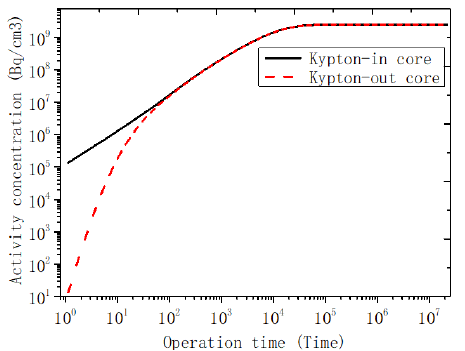
Figure 4. Krypton concentration in and out of the core varies with time after start-up